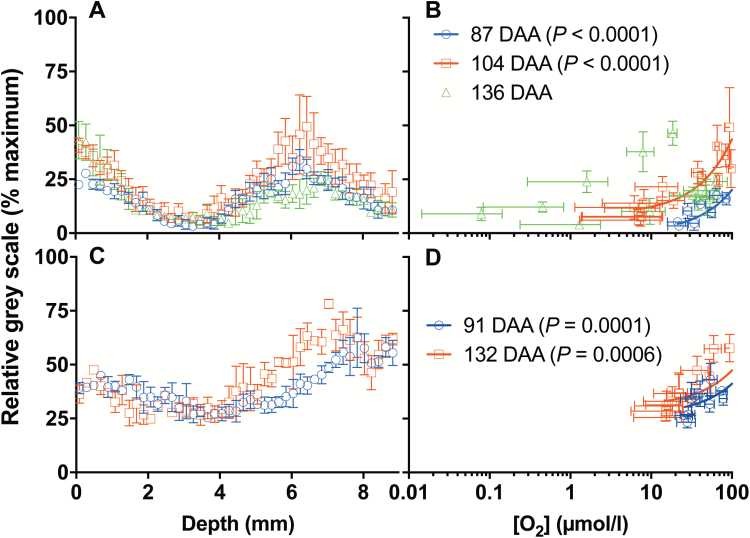
Correlation between living tissue fluorescence signal and [O2] profiles. Fluorescence signal [relative grey scale (% maximum)] from FDA stain (high value=higher living tissue) across the radius at the equator of Chardonnay (A) and Ruby Seedless (C). Correlation (Deming regression) between fluorescence signal intensity and [O2] at corresponding depths (log scale) in Chardonnay on 87 and 104 DAA (B) and Ruby Seedless on 91 and 132 DAA (D) ([O2] profiles shown in Fig. 1). Data are means ±SE, n=3.